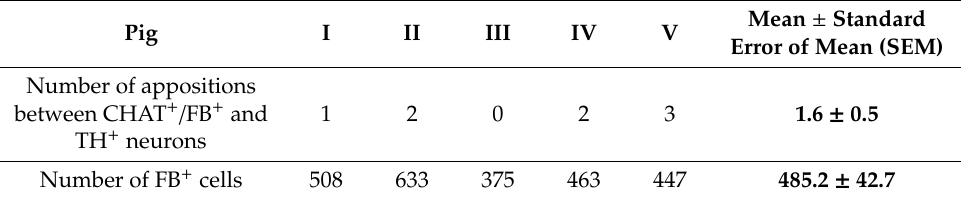
Table 2. Number of spatial appositions between FB + / ChAT + and TH +